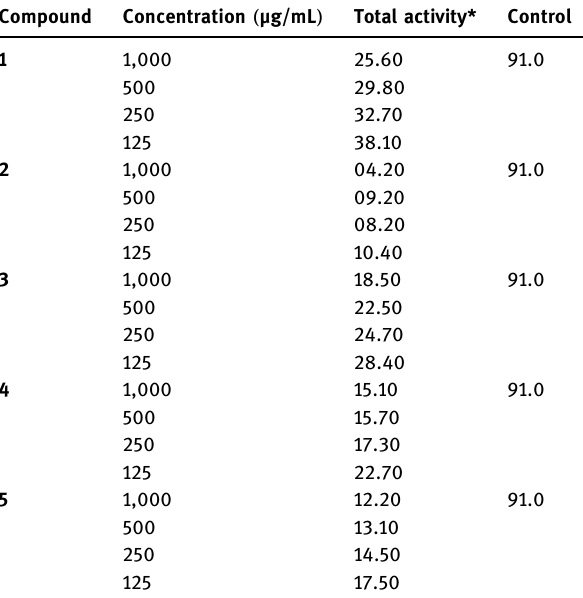
Table 5: E ff ect of the synthesized compounds on the activity of glucose - 6 - phosphatase